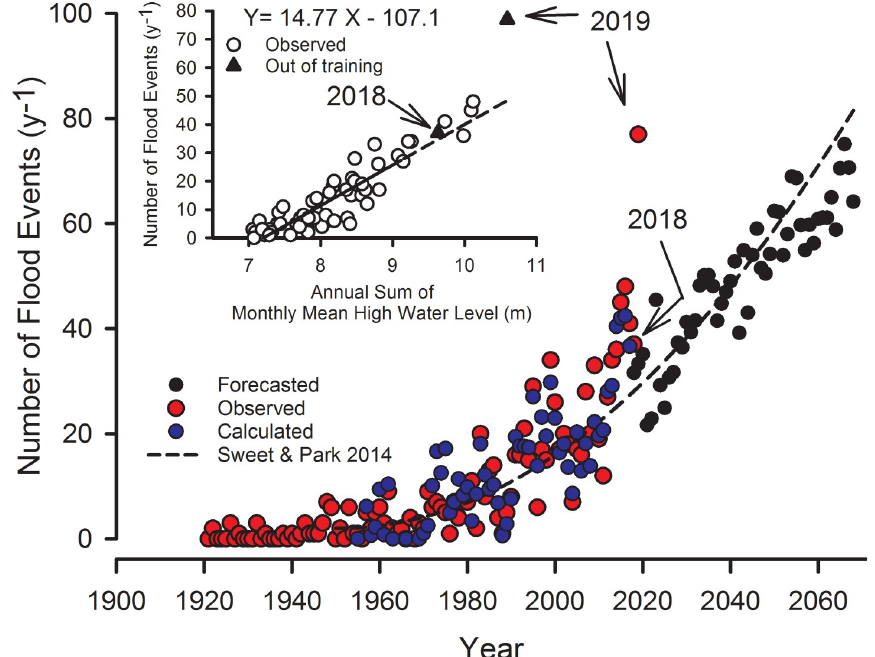
Fig 4. Annual observed and predicted flood events. The annual number of observed and forecasted flood events ( NF ) as a function time. The forecast was derived from the empirical relationship between NF and the annual sum of X 12 monthly MHW, shown in the inset, where NF ¼ 14 : 77 MHW (cid:0) 107 : 1 (R 2 = 0.83, p < 0.0001, N = 58). Calculated 1 NF are from observed monthly MHW data, and the forecasted flood events are from forecasted monthly MHW (Eq 2). Also shown (-—-) is NF from the quadratic model of Sweet and Park [7].